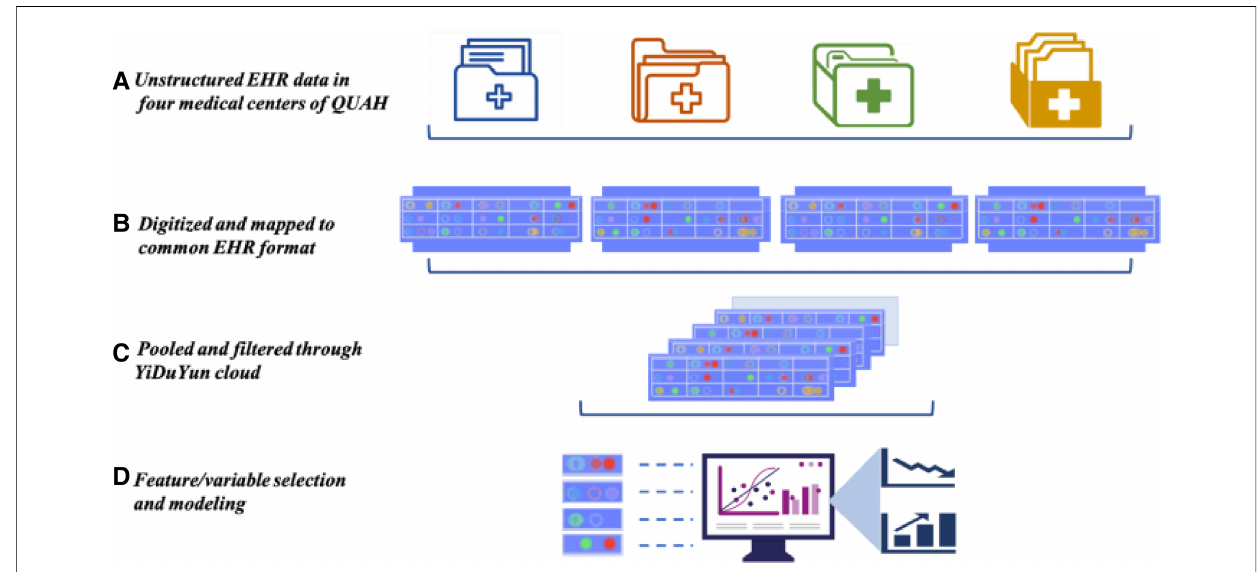
FIGURE 1 EHR from four medical centers of QUAH. ( A) EHR data collected from four medical centers. ( B ) Digitization of the collected data and using the standard EHR format. ( C ) Integration and fi ltering of selected patients. ( D ) Select relevant variables for download and analysis. EHR, electronic health